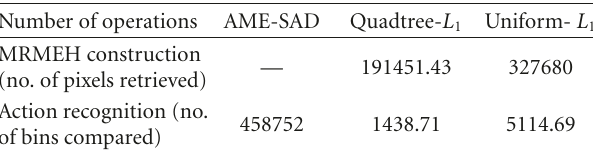
Table 8: Comparisons between AME-SAD and two kinds of partitioning methods in action recognition